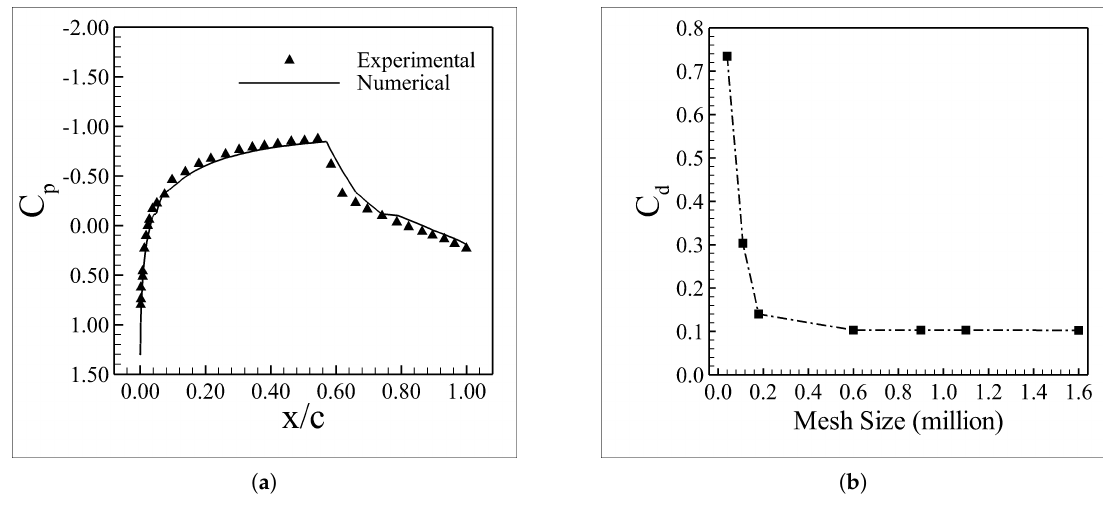
Figure 5. Comparison of pressure distribution and grid independence study of without jet